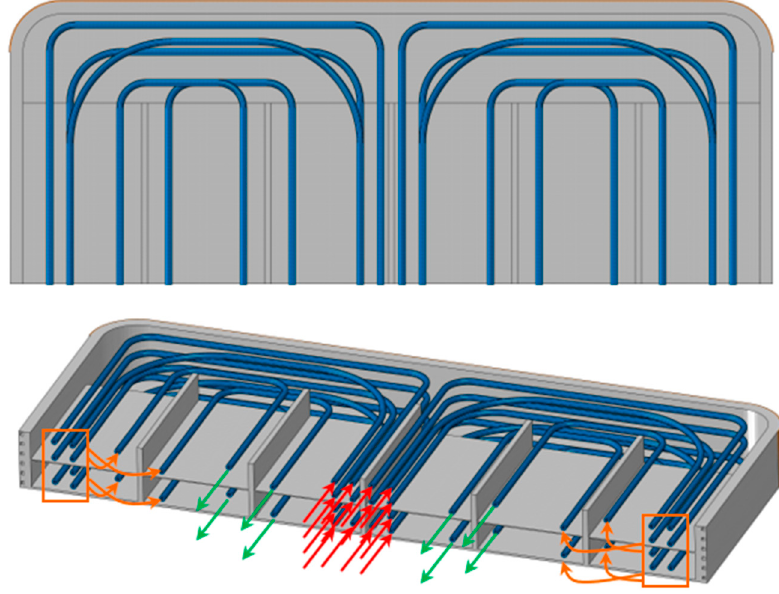
Figure 3. WCLL v06b DWTs layout and recirculation scheme (inlet in red, first outlet/recirculation in orange, exit in green).